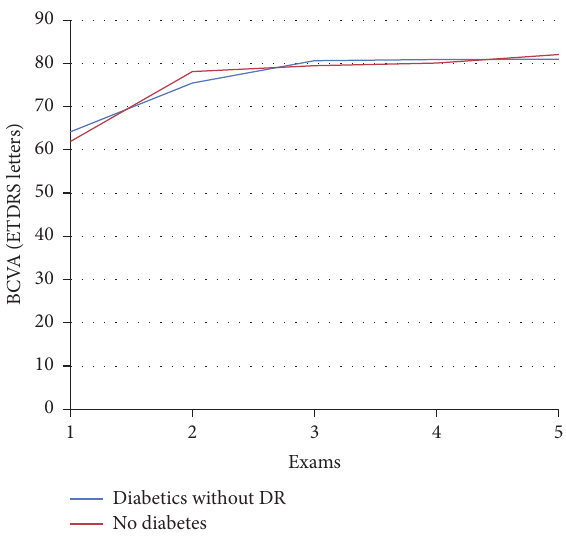
Figure 3: Central macular thickness on optical coherence tomogra- phy in 𝜇 m before (exam 1) and after cataract surgery: 1st day (exam 2), 1 month (exam 3), 3 months (exam 4), and 6 months (exam